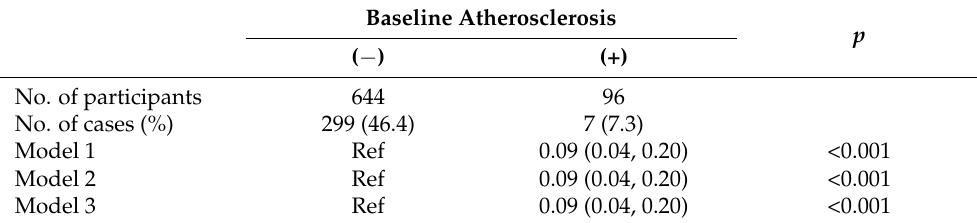
Table 2. Association between active arterial wall thickening and baseline atherosclerosis.